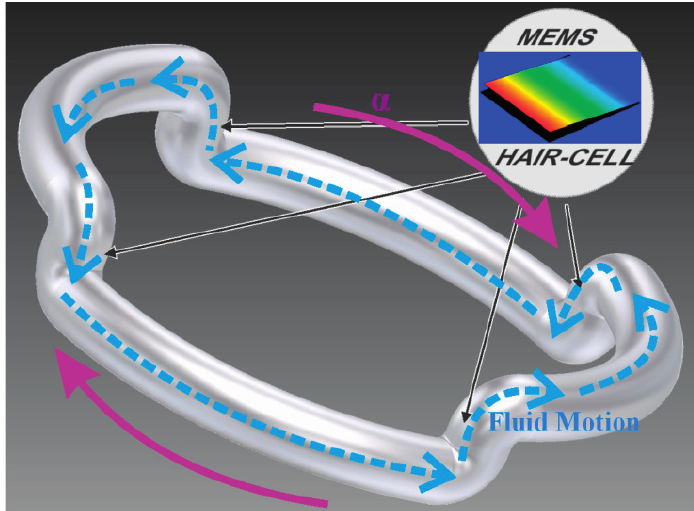
Figure 2. Illustration of the principle behind the sensor, which integrates four cantilevers (MEMS hair cells) at each of the layer transition points, i.e ., in the bulk-micromachined silicon layer, positioned at the locations shown by the black